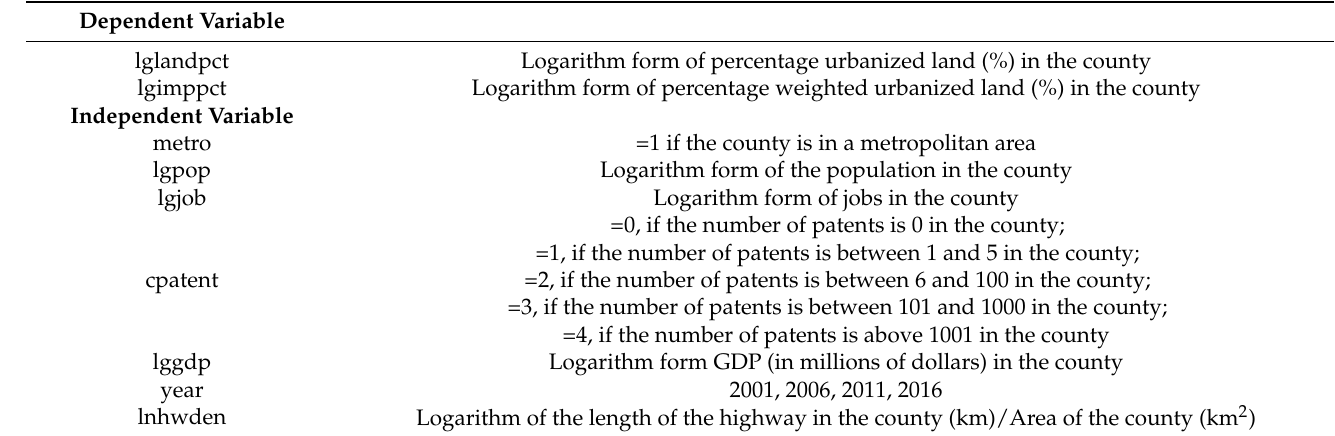
Table 3. Description of the variables in the mixed-effect regression.